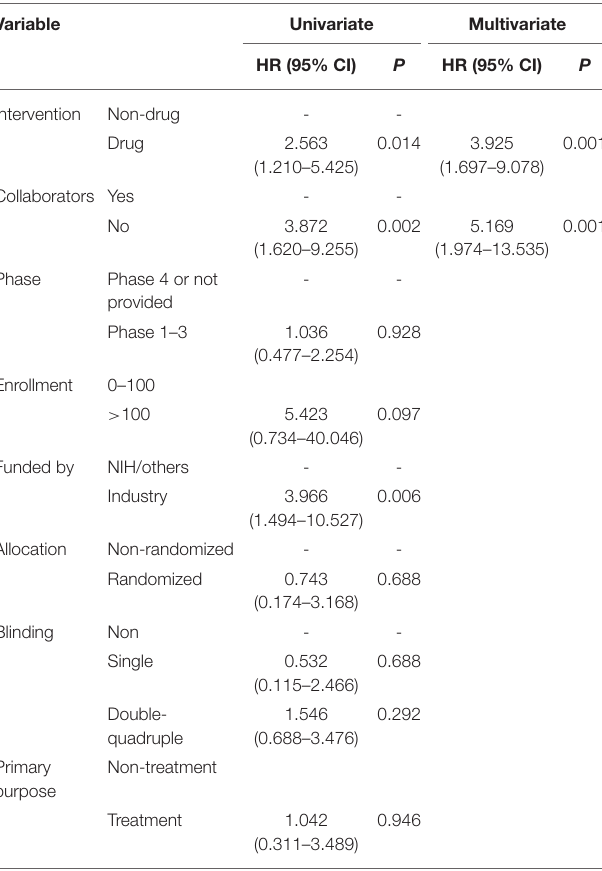
TABLE 3 | Cox regression analysis of OCD trials characteristics associated with early trial discontinuation. Variable